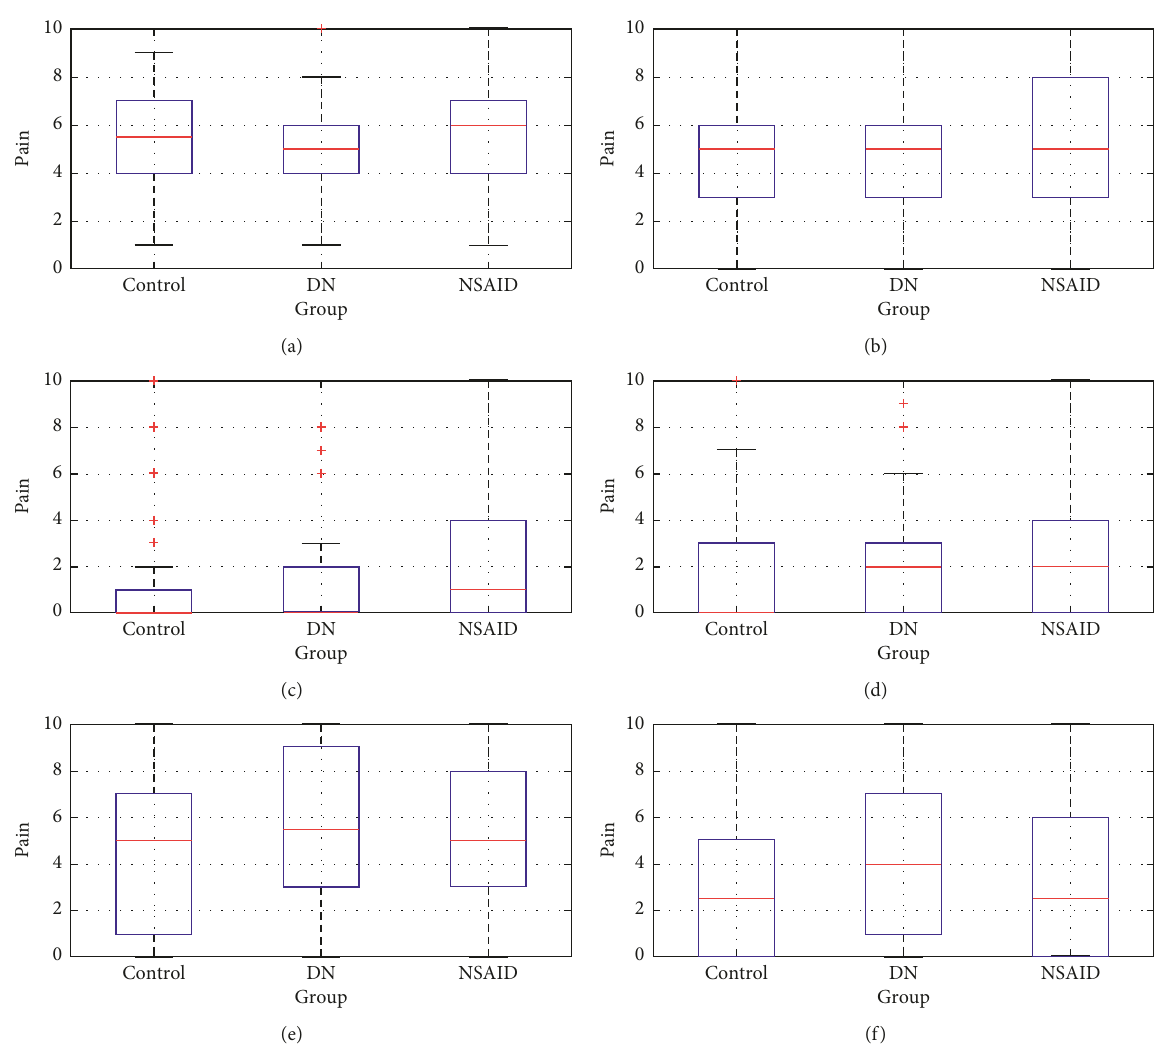
Figure 4: Box plots of responses of each VAS question in pretreatment test for all groups. Source: own. (a) Question 1. (b) Question 2. (c) Question 3. (d) Question 4. (e) Question